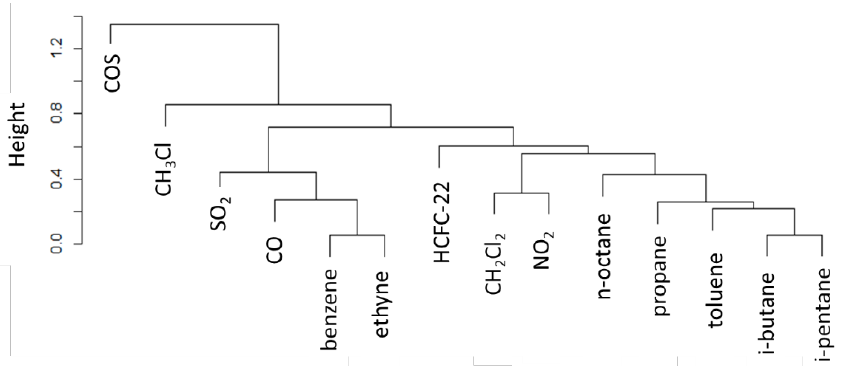
Figure 10. Dendrogram of cluster analysis of atmospheric trace gases for the residuals of the nighttime (00:00–04:00 UTC) dataset. Note that the y-axis denotes the cluster distance (indicated as “height”).